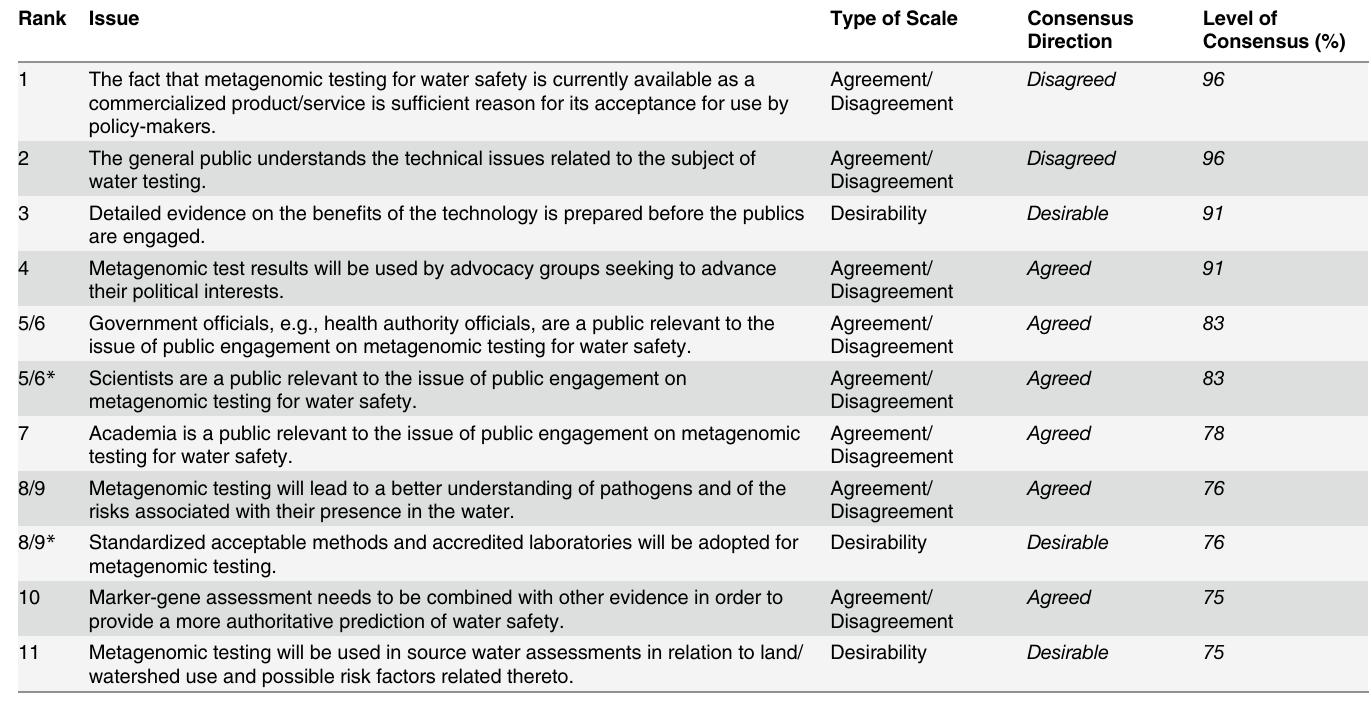
Table 4. Ranking of the Issues with CONSENSUS Among Experts in Regards to Metagenomic Tests for Water